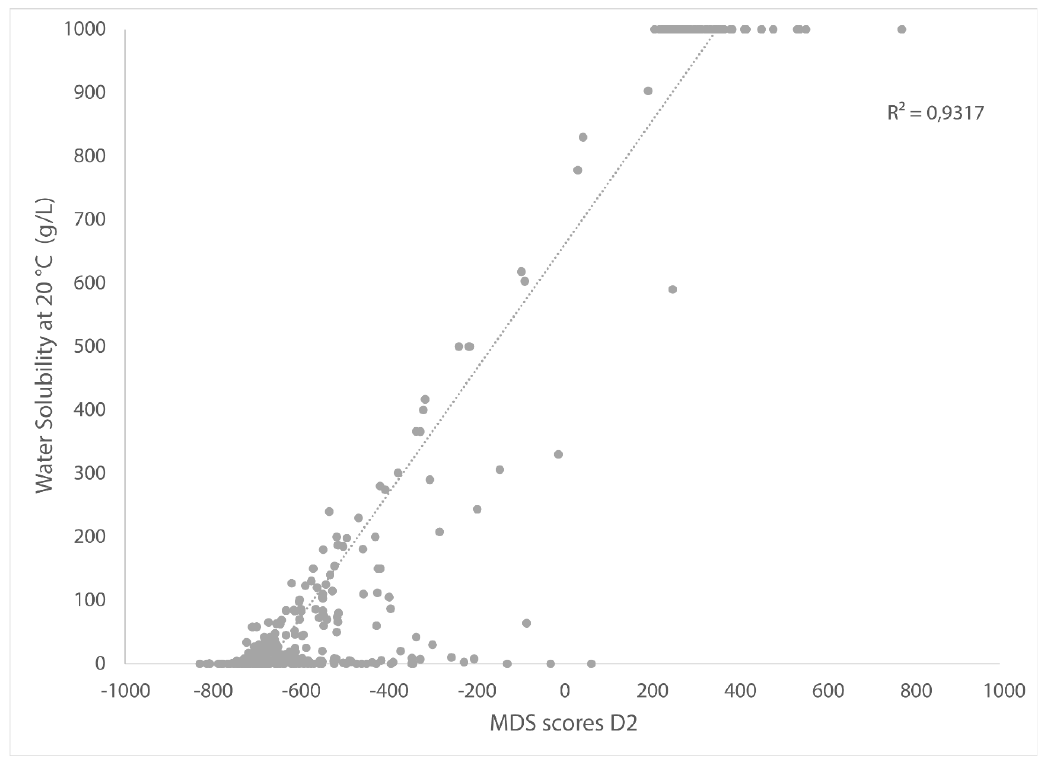
Figure 3. Correlation between D2 from MDS plot and water solubility. Molecules 2020 , 25 , x FOR PEER REVIEW